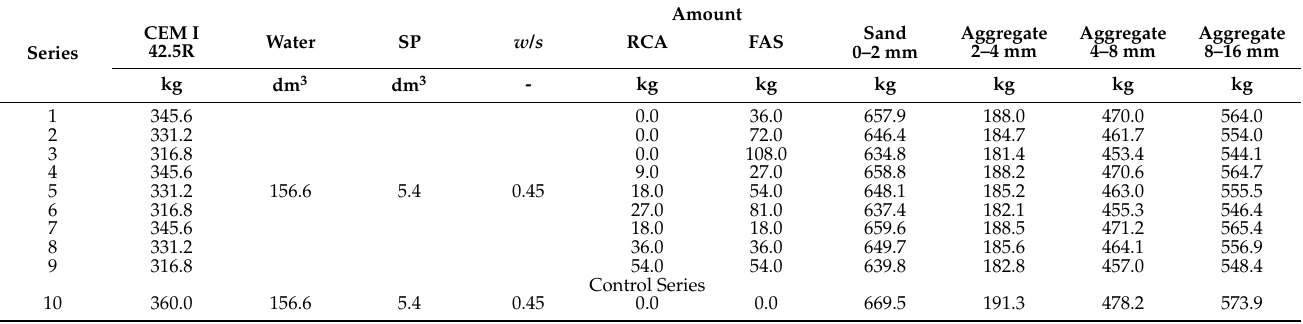
Table 6. The concrete mixture composition for 1 m 3